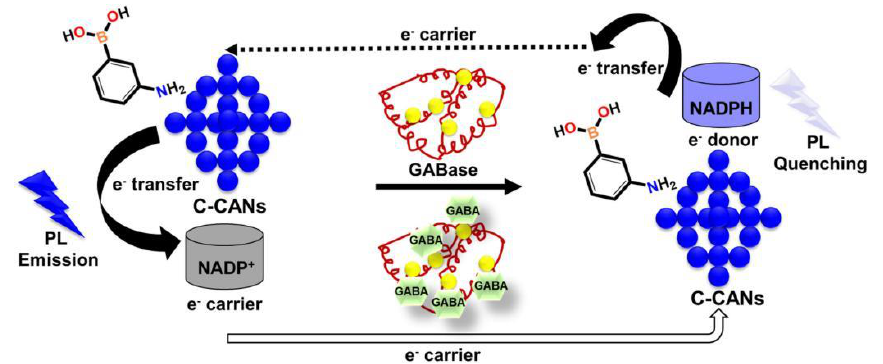
Figure 12. Schematic illustration of possible PL quenching mechanism for the detection of GABA using C-CANs with GABase. Adapted with permission from Sangubotla et al., 2022, copyright 2022. Reproduced with permission from Elsevier [81].